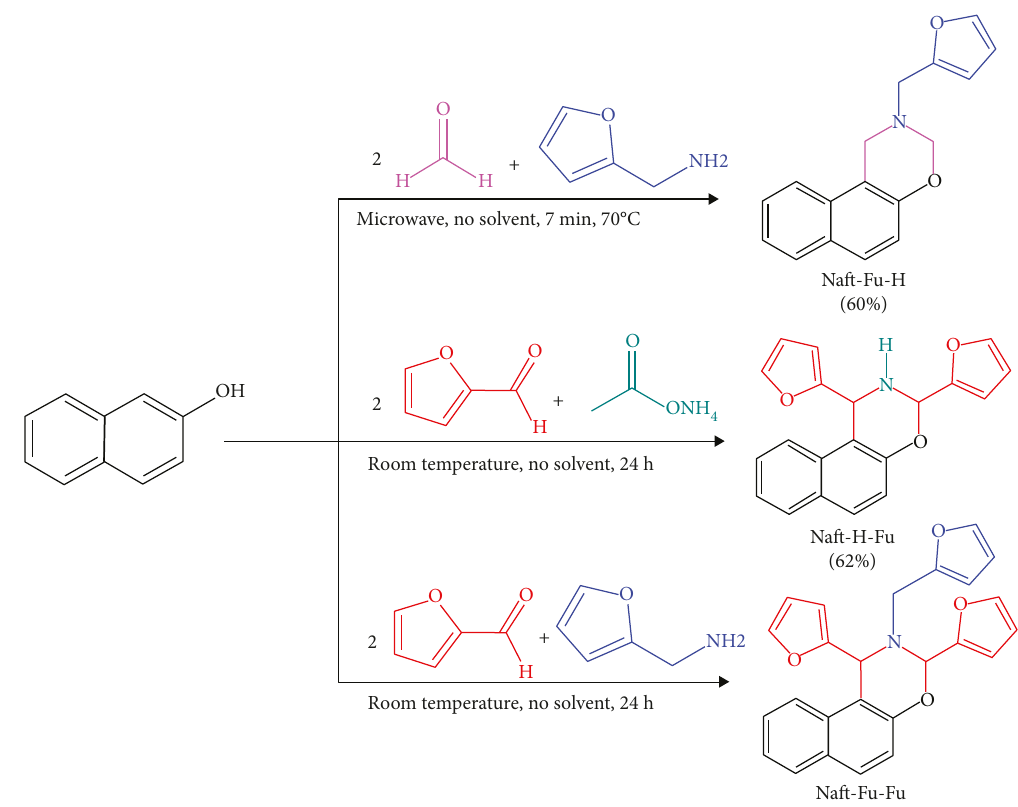
Figure 2: Synthetic scheme for the naphthoxazines containing furan groups.